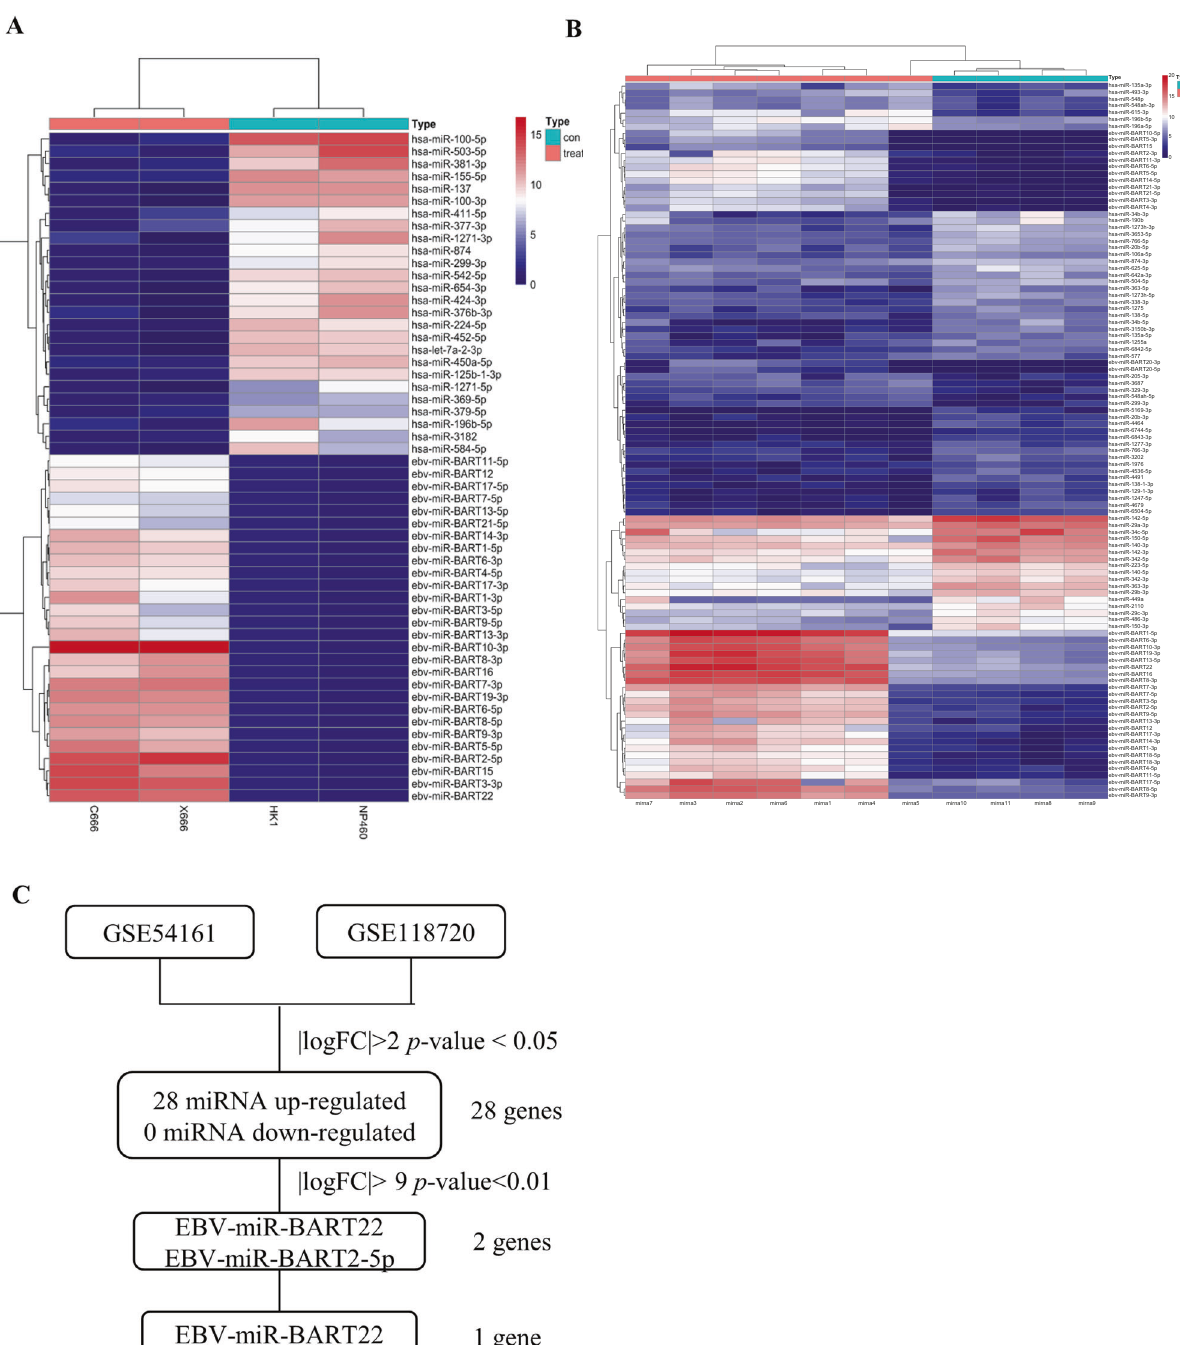
Fig. 1 EBV-miR-BART22 expression is upregulated in nasopharyngeal carcinoma. A The cluster heat maps showing the GSE54161 different expressed microRNAs in 2 lines of EBV positive and 2 lines of EBV-negative nasopharyngeal carcinoma cells. The blue and red stripes represent downregulated and upregulated microRNAs, respectively. B The cluster heat maps showing the GSE118720 different expressed microRNAs in 7 NPC biopsy specimens and 4 normal nasopharyngeal mucosal specimens. The blue and red stripes represent downregulated and upregulated microRNAs, respectively. C Microarray analysis was performed to identify EBV and nasopharyngeal carcinoma-associated microRNAs. Expression levels were analyzed in GSE54161, GSE118720. To narrow the range of values, the cut off with p -value < 0.01 and |fold change (FC)| > 2, as shown in the fl owchart. These data were integrated with tighter standards to identify the potential esophageal carcinoma and EBV-associated microRNAs (two microRNAs). EBV-miR-BART22 induces EMT to promote NPC cell metastasis screen, which yielded 5-, 6-, and 7-year AUC values of 0.91, in vitro and in vivo 0.892, and 0.914, respectively (Fig. 3C). These results demon- Lentivirus transfection was utilized to construct NPC cell lines strate that the EBV-miR-BART-22 assessment combined with stably overexpressing EBV-miR-BART-22 EBV ( − ) (CNE-1, CNE-2, TNM staging could constitute a risk-scoring system to predict SUNE-1). The relative transcript abundance of EBV-miR-BART-22 in NPC patient prognosis. Cell Death and Disease (2022)